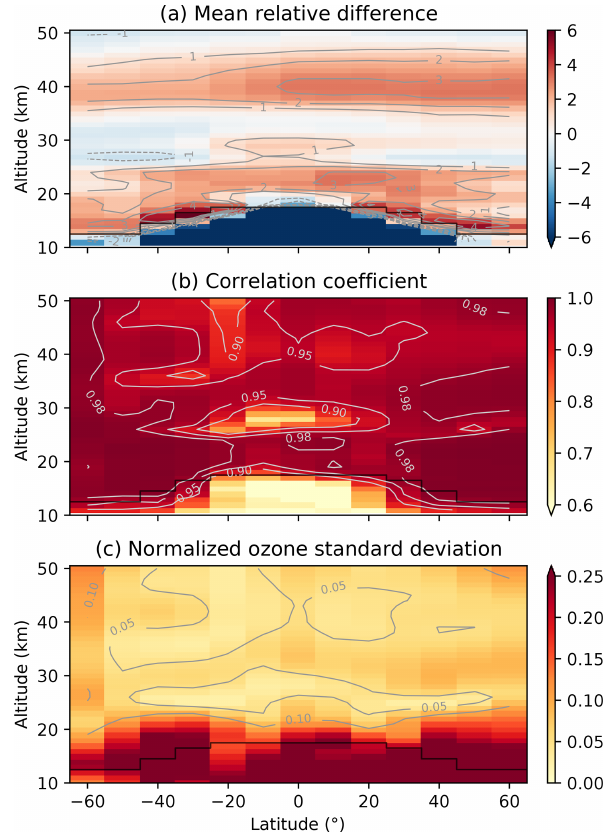
Figure A1. Comparison of OSIRIS v7.2 and v5.10 MZM ozone, with the (a) mean relative differences using v5.10 data as the refer- ence, (b) correlation coefficients, and (c) standard deviation of the v7.2 MZM ozone time series, normalized by the overall mean in each altitude–latitude bin. The black line in each panel shows the selected tropopause cutoff; data below this line are not included in other figures.